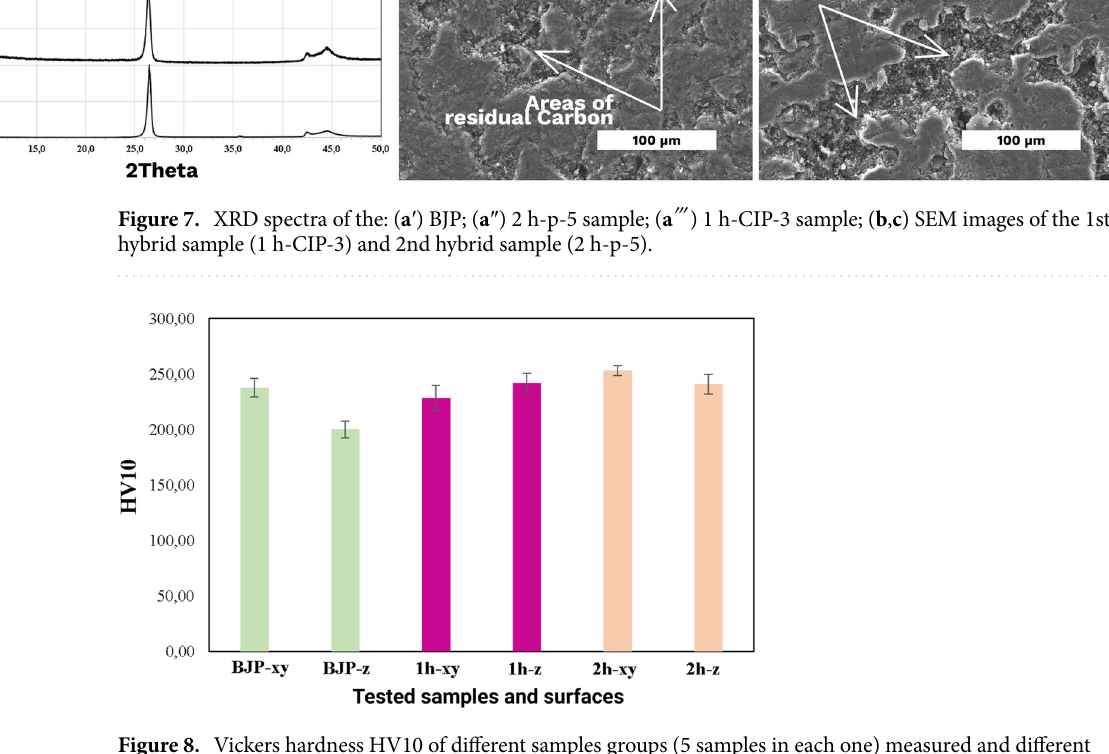
Figure 8. Vickers hardness HV10 of different samples groups (5 samples in each one) measured and different samples